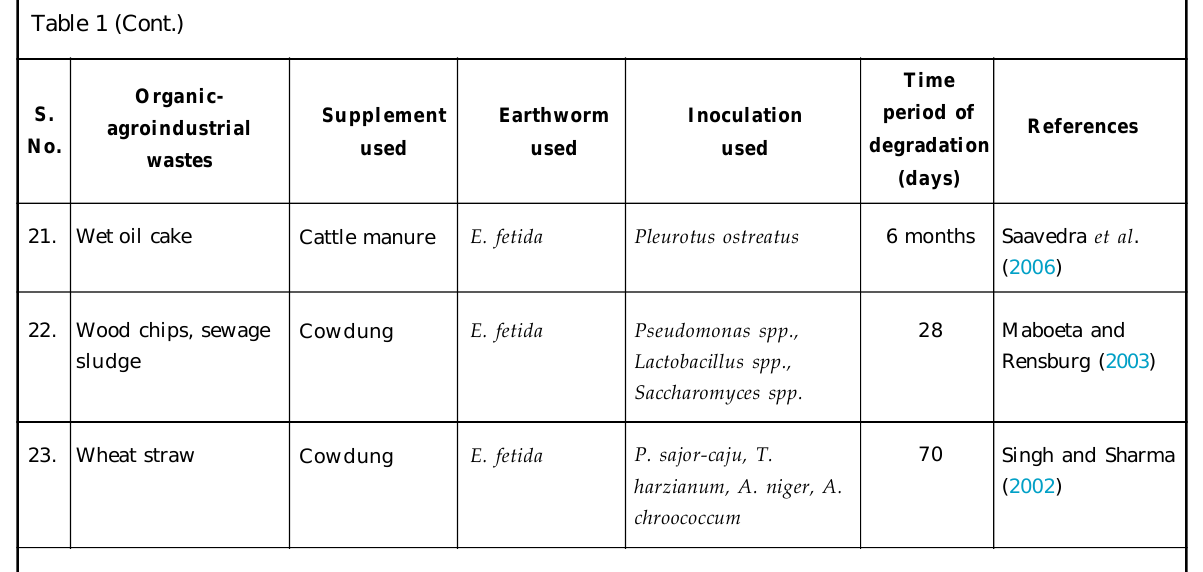
ReferencesTime period